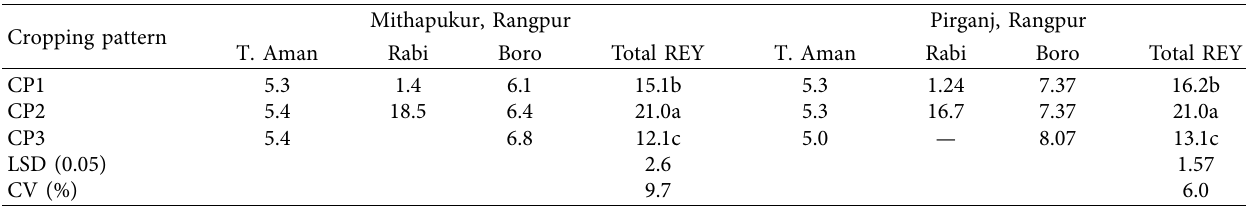
Table 3: Total rice equivalent yield (REY) of different cropping patterns (CP1: T. Aman-Mustard-Boro, CP2: T. Aman-Potato-Boro, CP3: T. Aman-Fallow-Boro) at Rangpur during 2018–2019. Cropping pattern